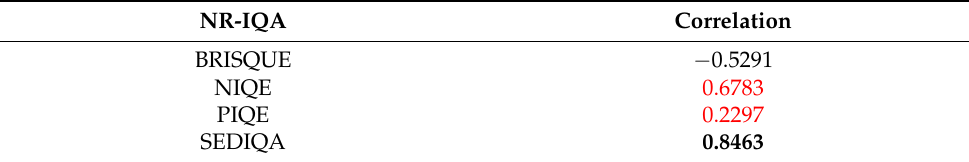
Table 2. Correlation of NR-IQAs with OCR Accuracy. Red denotes incorrect correlation.